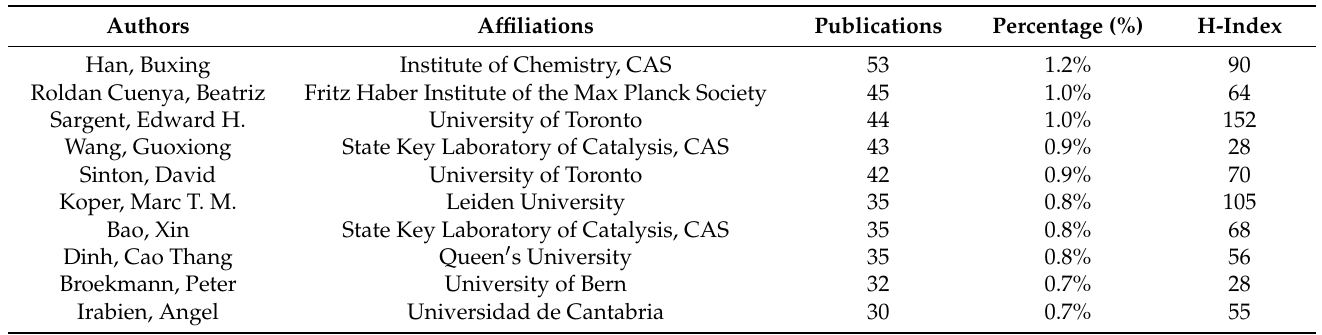
Table 3. Top ten most published authors during 2005–2022.